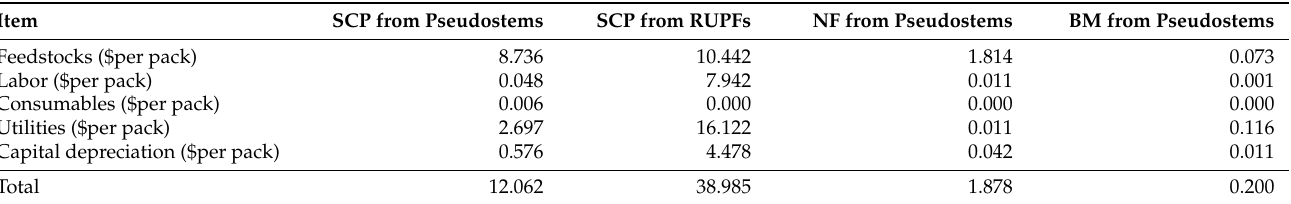
Table 9. Operating and depreciation costs per unit of products for the simulated process